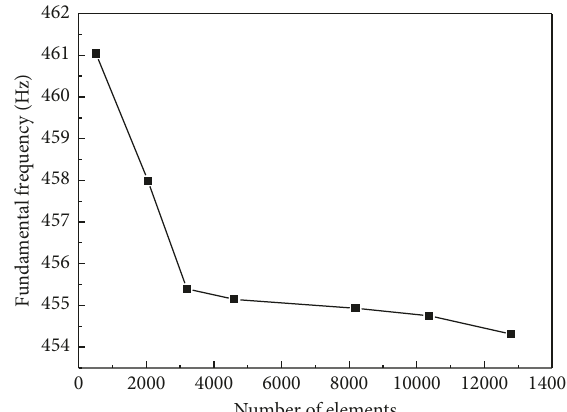
Figure 5: Mesh sensitivity study.